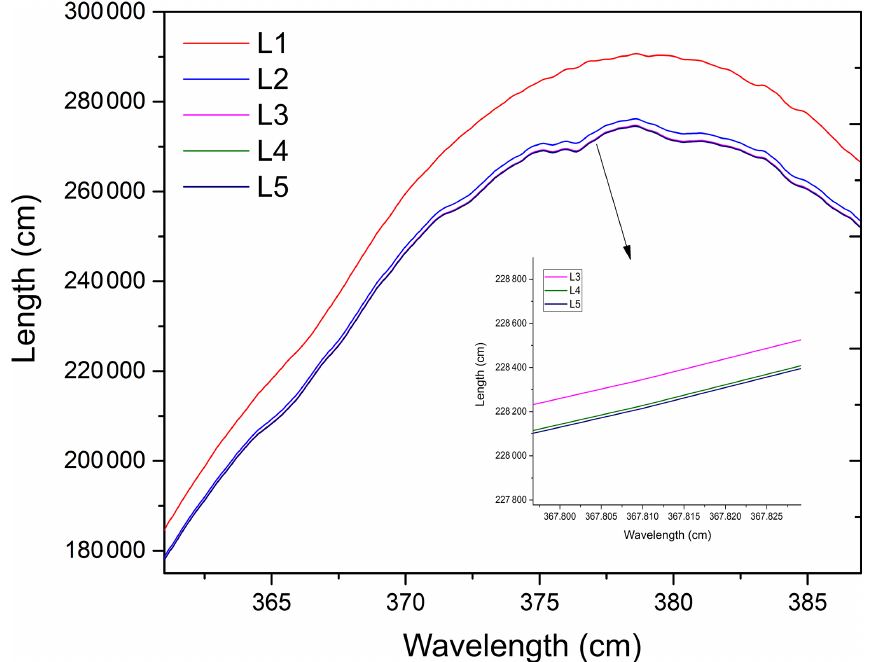
Figure 5. Example of the effective absorption optical path lengths calculated during the consecutive iterations (L1, L2, L3, L4, and L5) of an iterative retrieval algorithm. As the number of iterations increases, the effective absorption optical path gradually converges. Table 1. The detection limits of HONO and NO 2 measured by various IBBCEAS